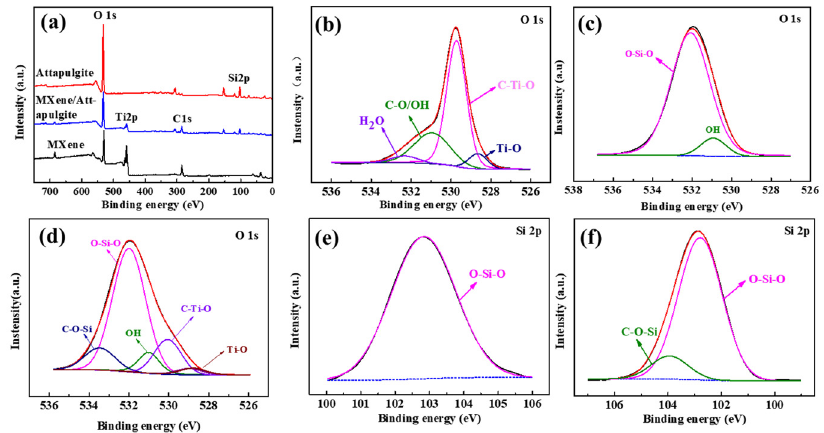
Figure 3. ( a ) XPS survey spectra of MXene, attapulgite, and MXene/attapulgite composite (1:2); high-resolution O 1s XPS spectra of ( b ) MXene, ( c ) attapulgite, and ( d ) MXene/attapulgite composite (1:2); high-resolution Si 2p XPS spectra of ( e ) attapulgite and ( f ) MXene/attapulgite composite (1:2).